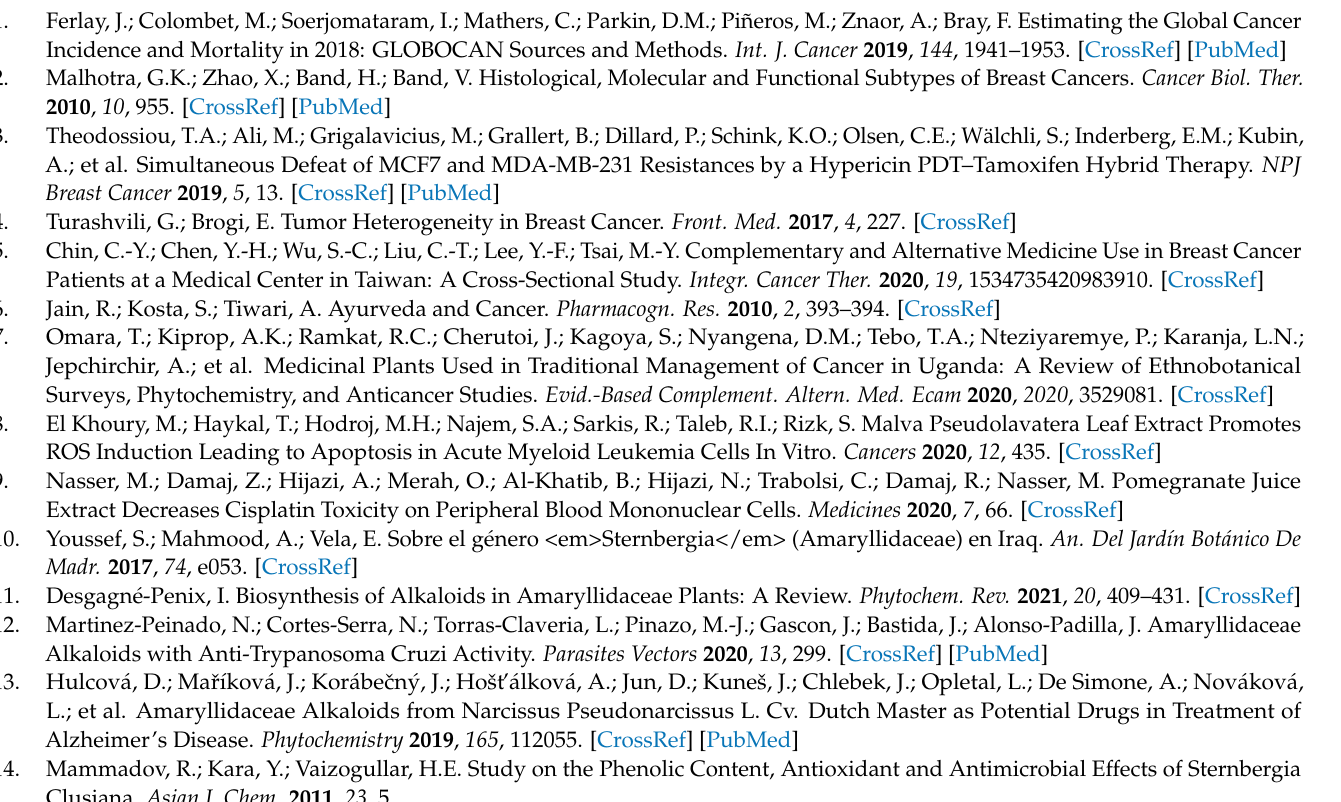
in Figure 3D; Figure S3: Full length blots of MDA MB 231 reported in the manuscript in Figure 4A; Figure S4: Full length blots of MDA MB 231 reported in the manuscript in Figure 4A; Figure S5: Full length blots of MCF 7 reported in the manuscript in Figure 4B; Figure S6: Full length blots of MCF 7 reported in the manuscript in Figure 4B; Figure S7: Full length blots of MDA MB 231 reported in the manuscript in Figure 5; Figure S8: Full length blots of MCF 7 reported in the manuscript in Figure 5. In Trial 2, we had to cover the top part of the blot and increase the exposure to be able to see the cleaved form of caspase 8 due to overexpression of the upper bands. Table S1: Targeted identification of alklaoid derivatives in ScBEE using